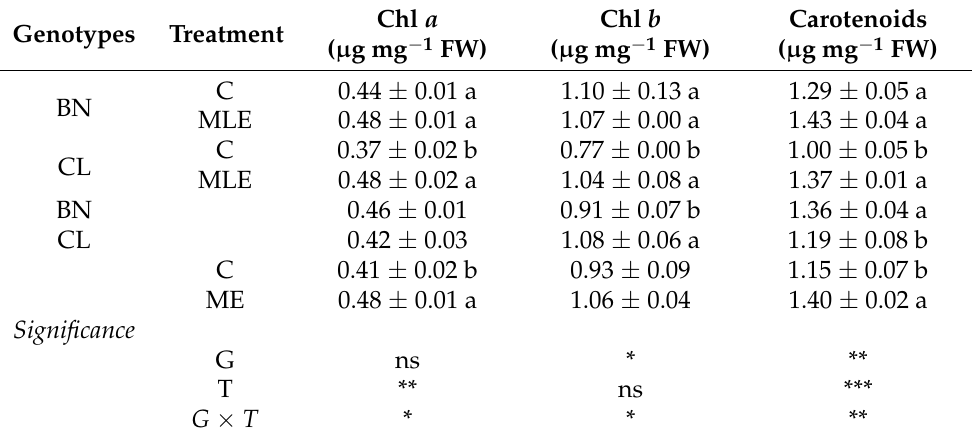
Table 4. Effect of MLE application on chlorophyll a and b ( µ g mg − 1 FW), and carotenoids ( µ g mg − 1 FW) on plant of BN and CB. Extract was sprayed 15, 30 and 43 days after sowing.